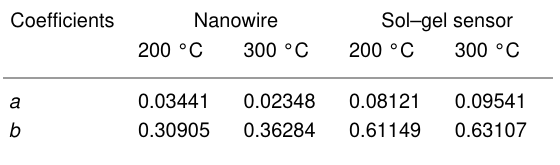
Table 1: parameters of power function approximation of calibration